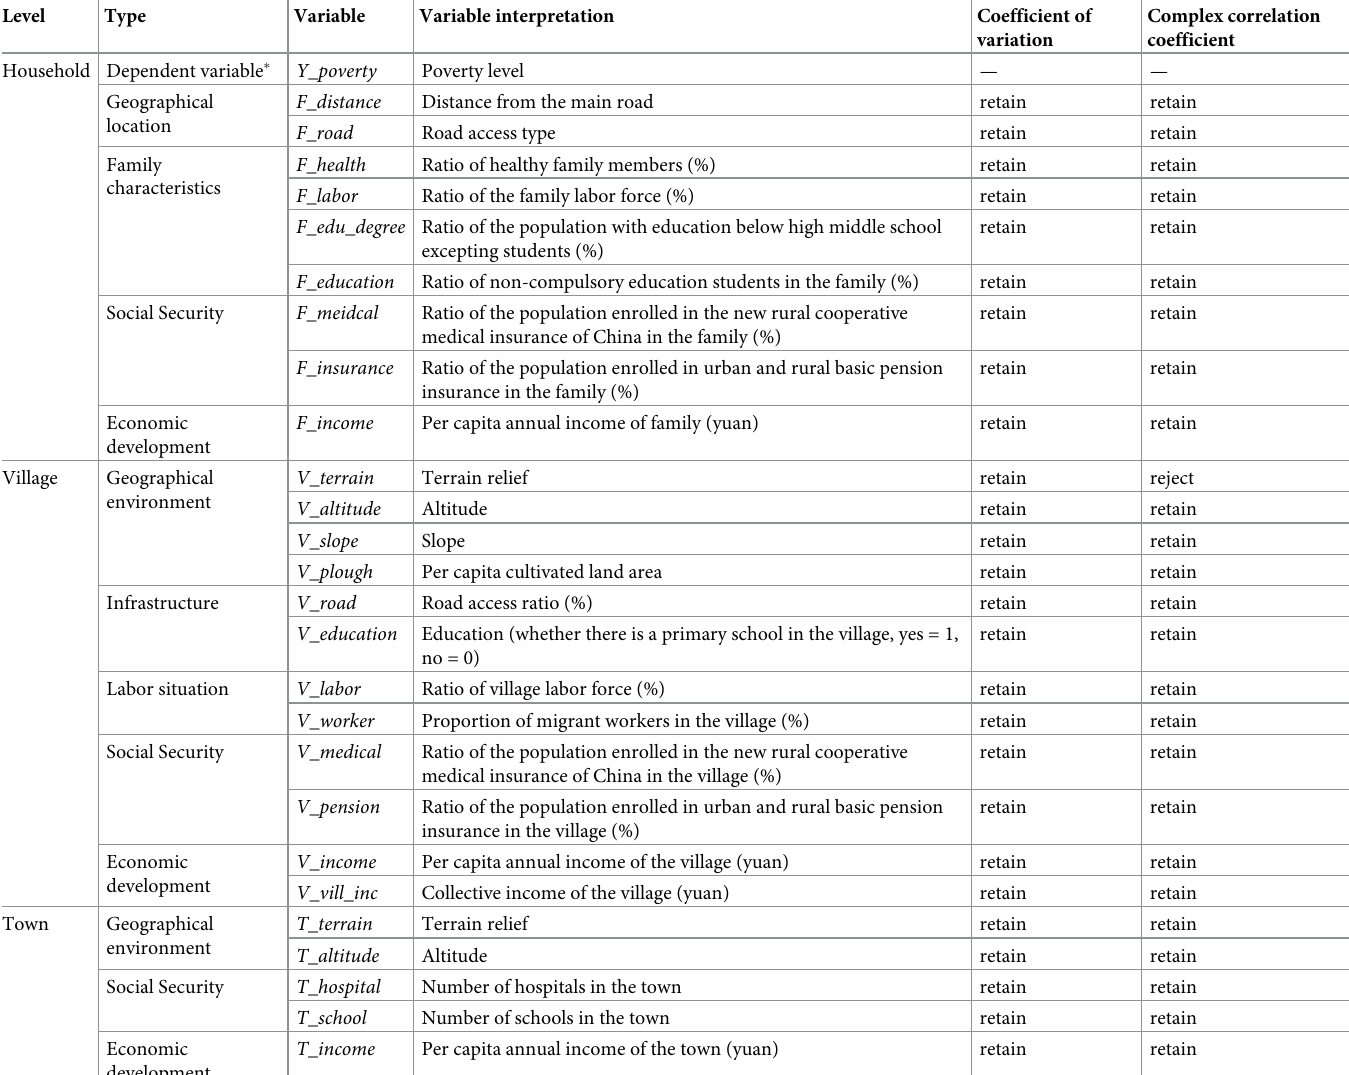
Table 1. Indicators of household-village-town